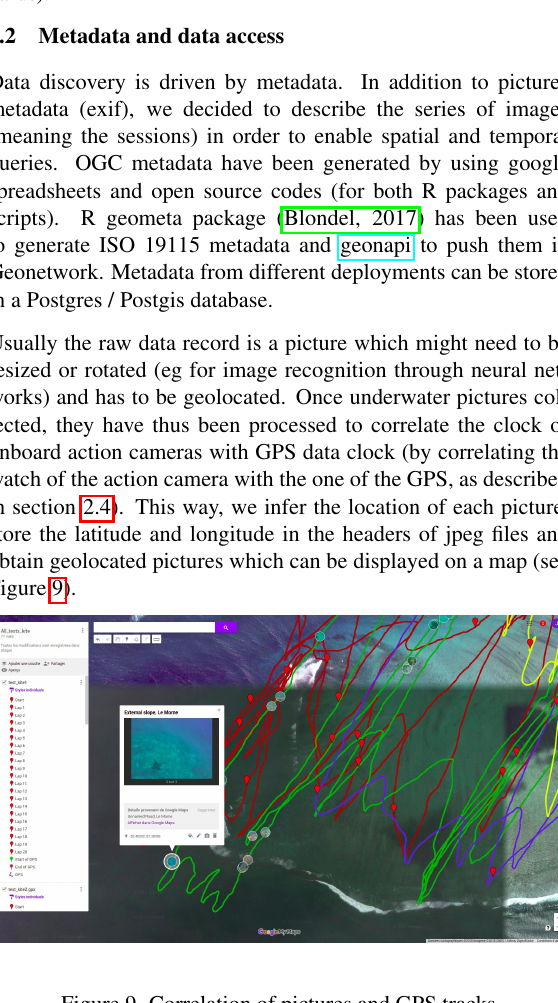
Figure 9. Correlation of pictures and GPS